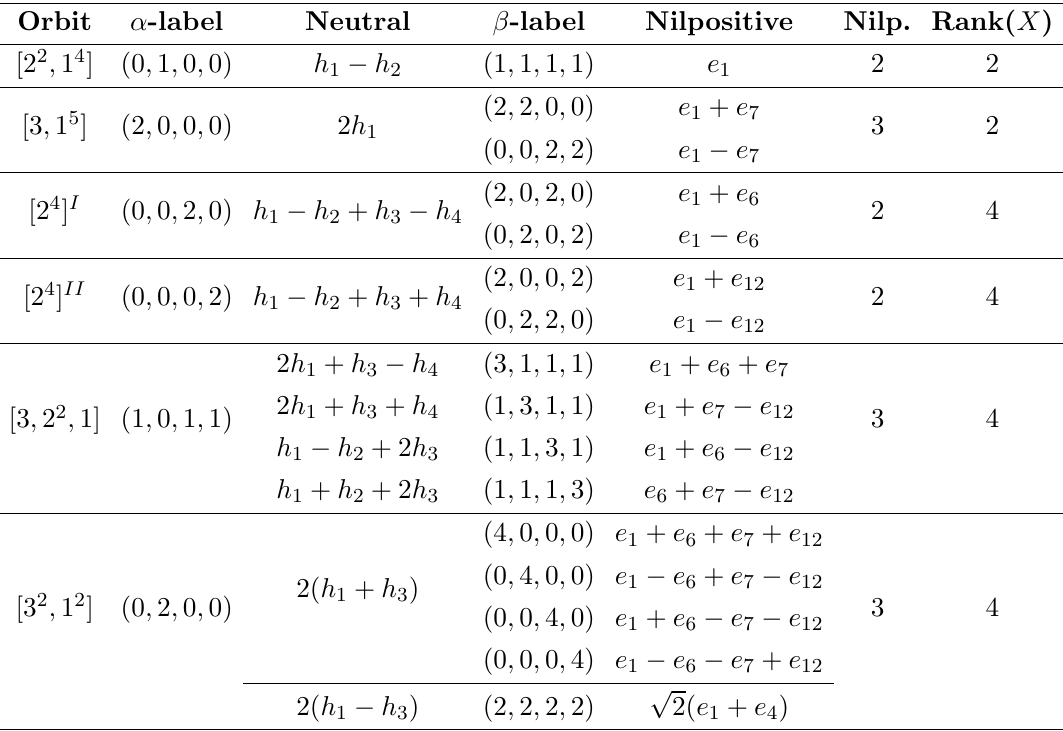
Table 1 . List of the smaller nilpotent orbits of so (4 ; 4) classi(cid:12)ed by (cid:11); (cid:12) -labels. We have also listed representative neutral and nilpositive elements that together form a standard triple f h; e; f g in the corresponding orbit. Nilp. and Rank( X ) denote the nilpotency degree (smallest n such that X n = 0) and the matrix rank of the orbit in the 8 (cid:2) 8 vector